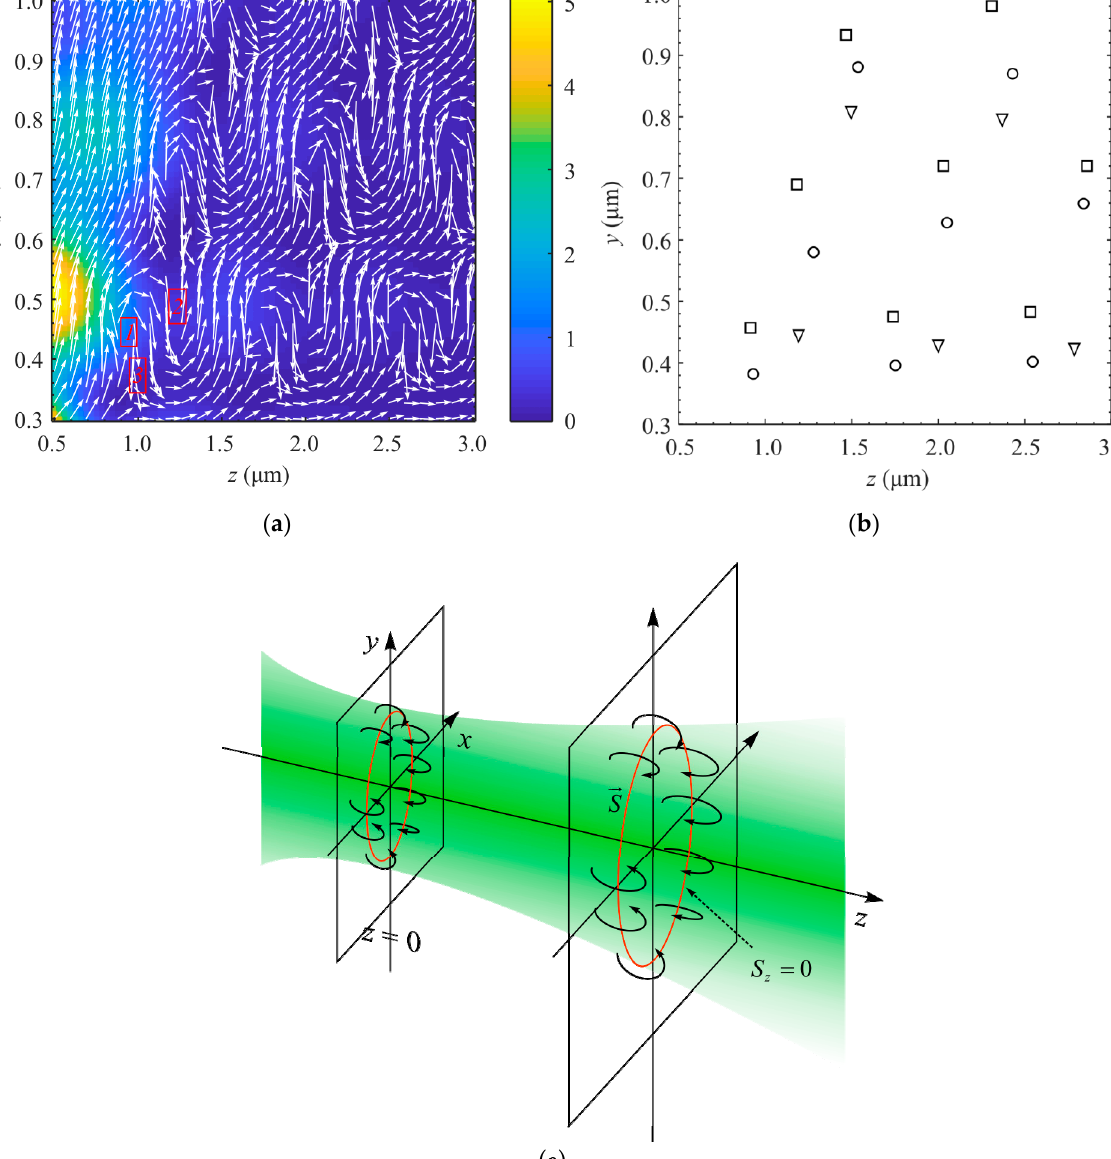
Figure 3. ( a ) Intensity distribution (color) and directions of the Poynting vector (arrows) in the YZ plane and ( b ) positions of the points at which the Poynting vector is zero (squares-vortex with clockwise rotation, triangles-vortex with counter- clockwise rotation arrows, circles-saddle points). The numbers indicate the individual areas shown in the figures below. ( с ) Schematic representation of a toroidal vortex of energy.